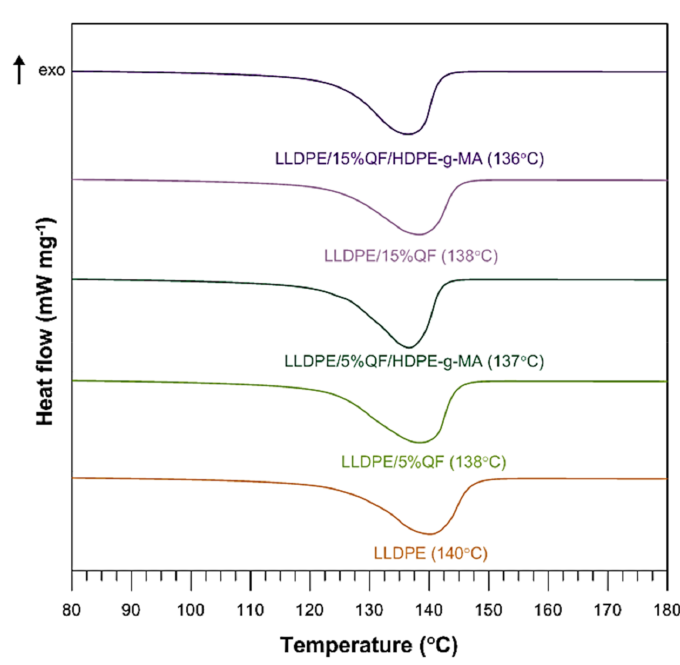
Figure 8. DSC curves for the pure LLDPE.